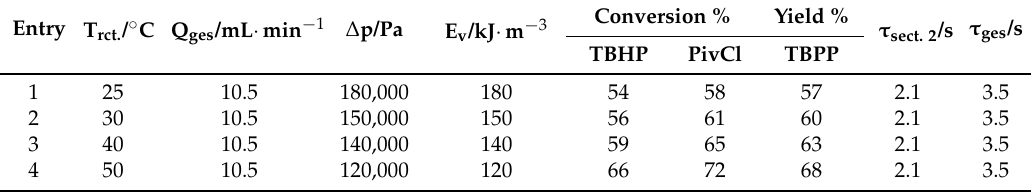
Table 2. Energy density at a total flow rate of 10.5 mL ¨ min ´ 1 by using the OMR for TBPP synthesis at different reaction temperatures.